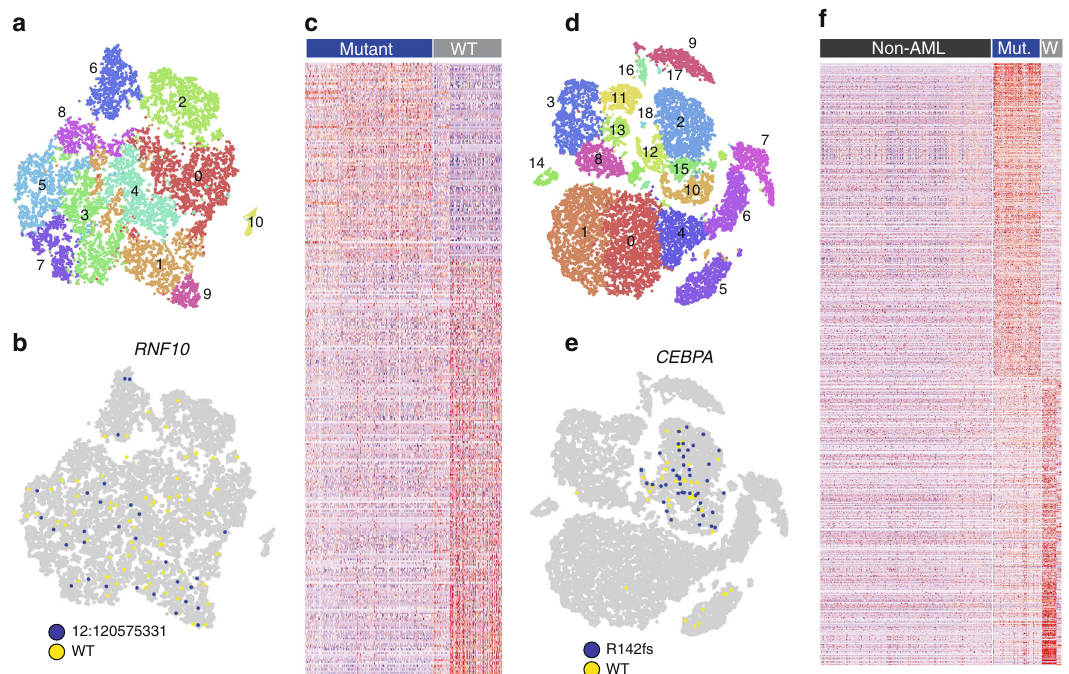
Fig. 7 Additional mutation-associated gene expression signatures. a t-SNE plot of 508084, cells colored by graph-based cluster. b Cells colored according to coverage at the RNF10 NULL site (mutant = blue, wild-type = yellow). c Genes that are differentially expressed between mutant-rich and mutant-poor clusters. d t-SNE plot of 809653, cells colored by graph-based cluster. e Cells colored according to coverage at the CEBPA R142fs site (mutant = blue, wild- type = yellow). f Genes that are differentially expressed between mutant-rich and mutant-poor clusters; non-AML cells shown for